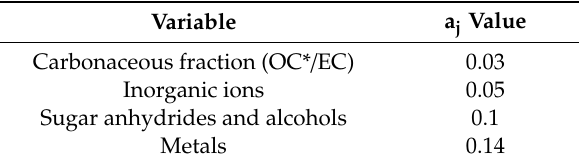
Table 1. Additional error coe ffi cients used in Equation (1) for each variable.